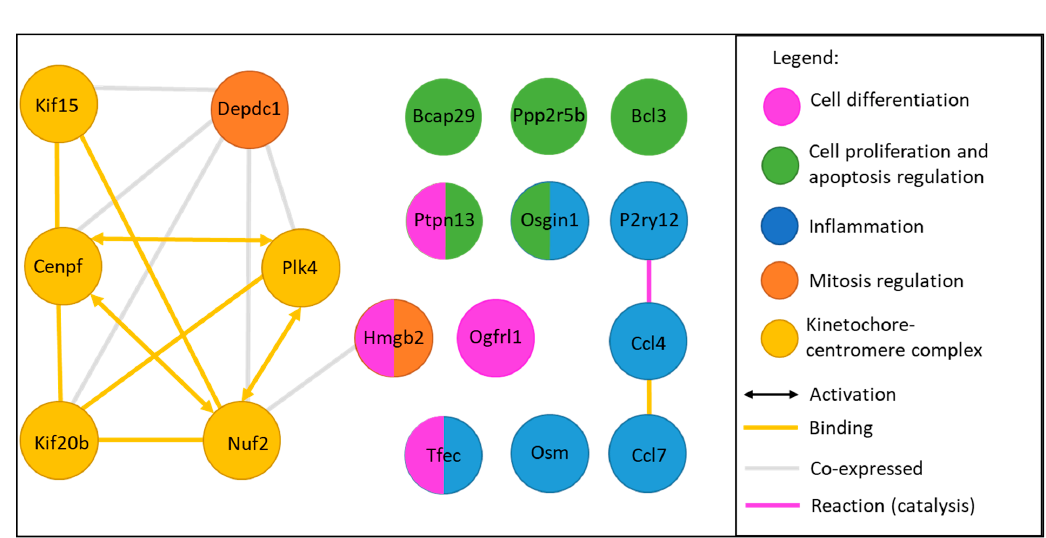
Figure 6. Interactions and function groups of the 18 common dysregulated genes (adapted from an analyze by String 11.1 Database, functions groups were determined through UniProt, GeneCards and PubMed researches). Table 5. ( A ) Gene ontology (GO) biologic process (20 most dysregulated GO-term); ( B ) KEGG pathways and ( C ) reactome pathways of the 18 common dysregulated genes (analyzed by String 11.1 Database).